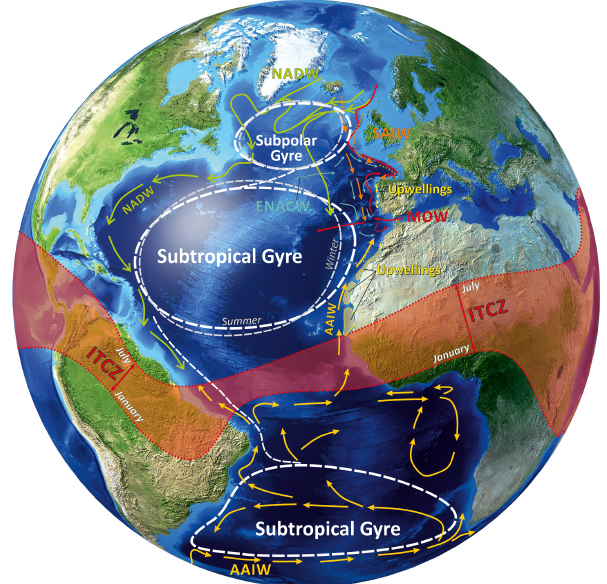
Figure 1. Sketch of the intermediate water circulation in the At- lantic Ocean. The position of the main gyres, the Intertropical Confluence Zone (ITCZ) and circulation of the AAIW, SAIW, ENACW and MW w< are indicated. Compilation is based on Krauss et al. (1987), Stramma and Siedler (1988), Faugères et al. (1993), Iorga and Lozier (1999), Pickart et al. (1999), Stramma and England (1999), Coulbourne and Foote (2000), Lavander et al. (2000), Rhein (2000), Fratantoni (2001), Raymo et al. (2004), Mackie (2005), Peliz et al. (2005, 2009), Rahmstorf (2007), Stein (2007), Gil et al. (2008), Yashayaev and Clarke (2008), Hernández-Molina et al. (2011) and references therein, Cheng et al. (2012) and Pérez et al. (2013).